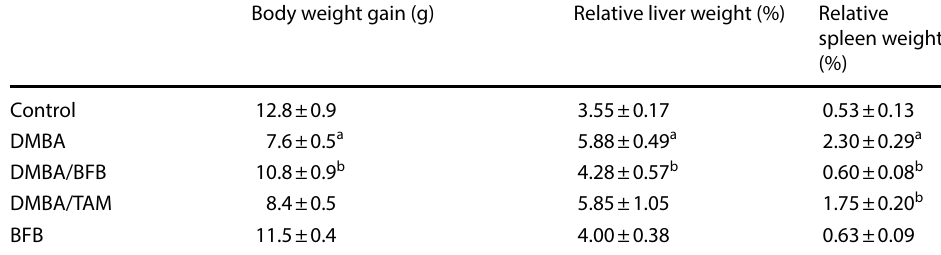
Table 1 Effect of bithiophene- fluorobenzamidine (BFB) treatment on the body weight gain, and relative weights of